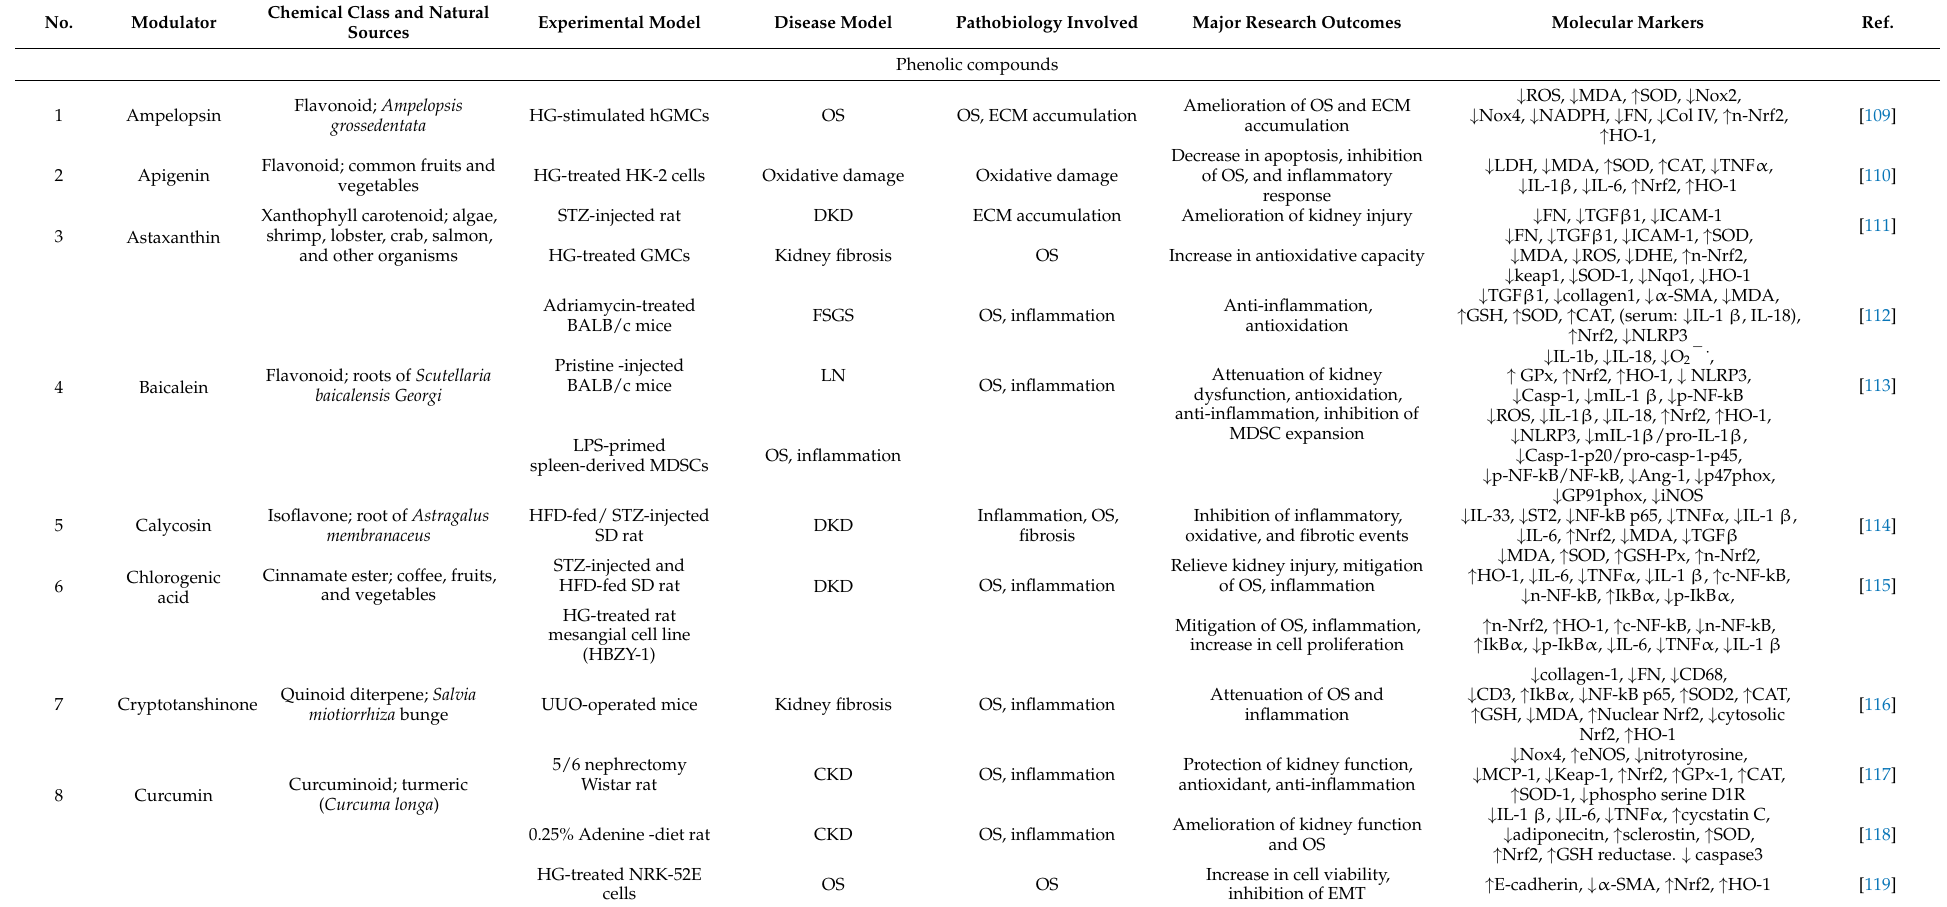
Table 1. Kidney protective effects provided by phenolic compounds of phytochemicals targeting the Nrf2-HO-1 signaling